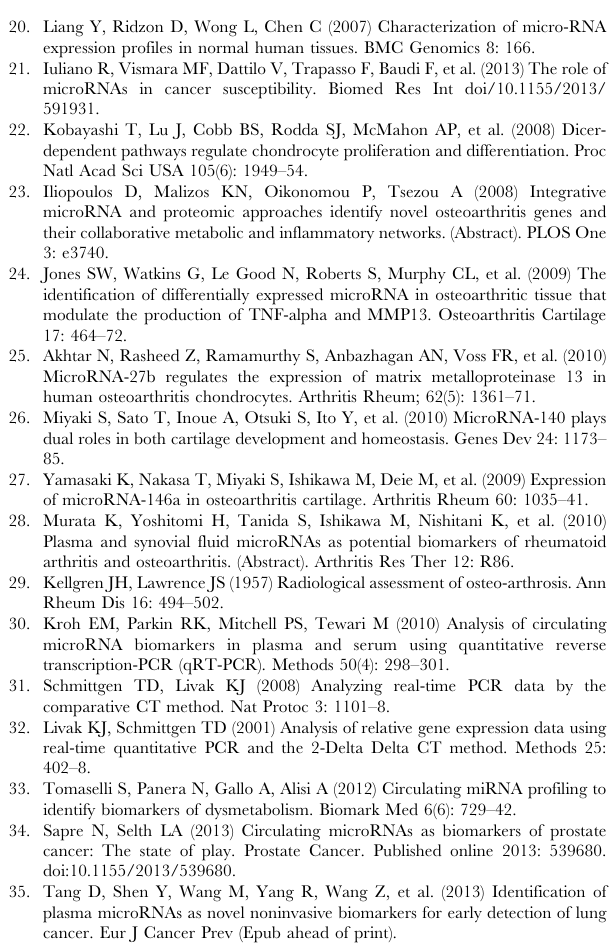
regulated in plasma samples of Osteoarthritis (OA) according to an in silico analysis by means of the miRecords database. Table S1 MicroRNA (miRNA) selected for TaqMan profiling Low Density Arrays (TLDA) with highest differential expression between normal patients and patients with Osteoarthritis (OA). About 107 genes were regulated by